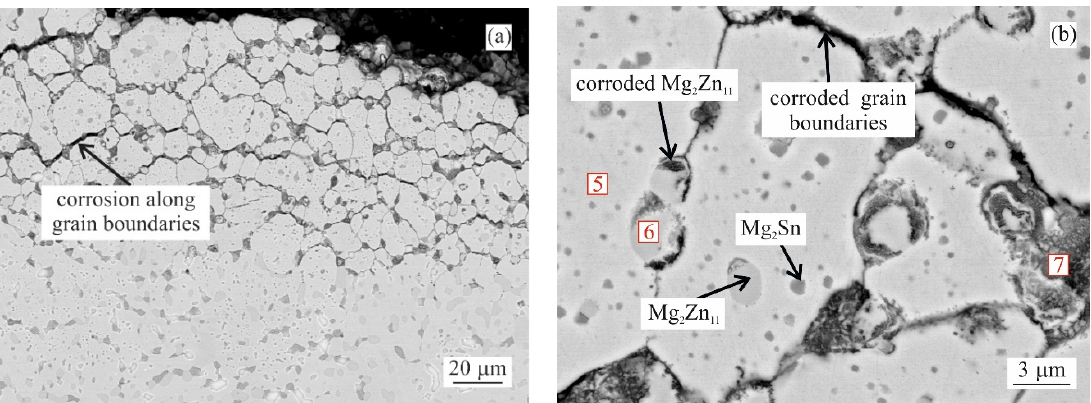
Figure 9. MZ+2.0Sn annealed microstructure after 1000 h in NSST affected by IG corrosion: ( a ) overview, ( b ) detail. Table 3. EDS chemical composition of selected sites (at.%). Site No. (as Labeled in Figures 8 and 9) Chemical Element